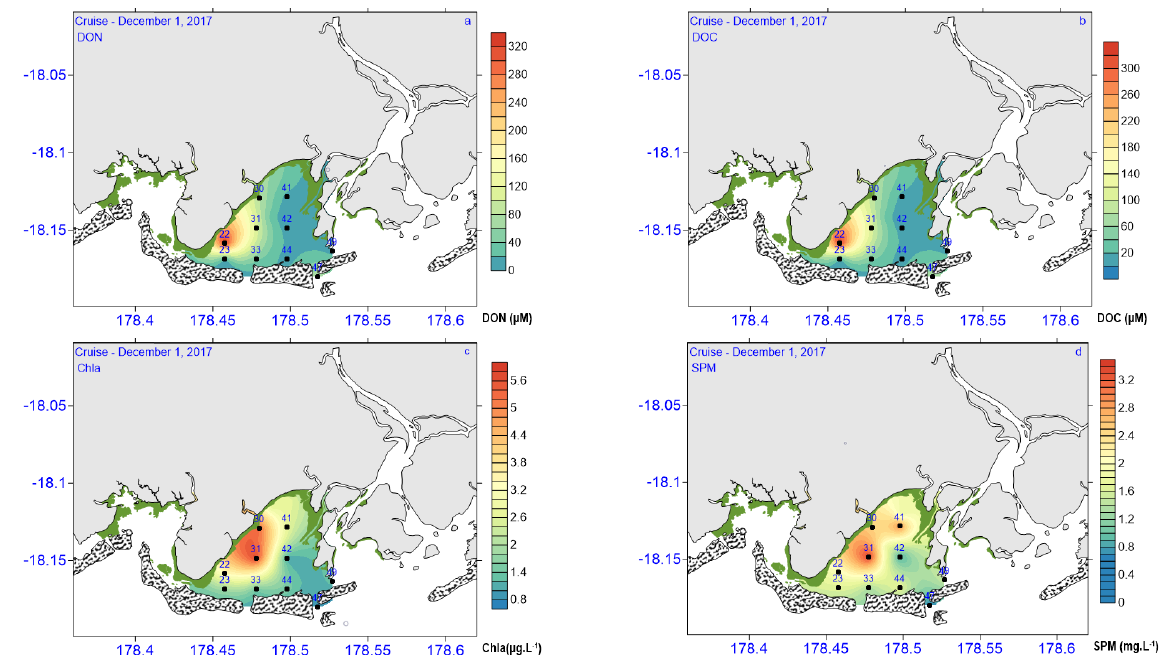
Figure 4. Color maps for biogeochemical variables ( a ) dissolved organic nitrogen (DON); ( b ) dissolved organic carbon (DOC); ( c ) Chla and ( d ) suspended particulate matter (SPM).